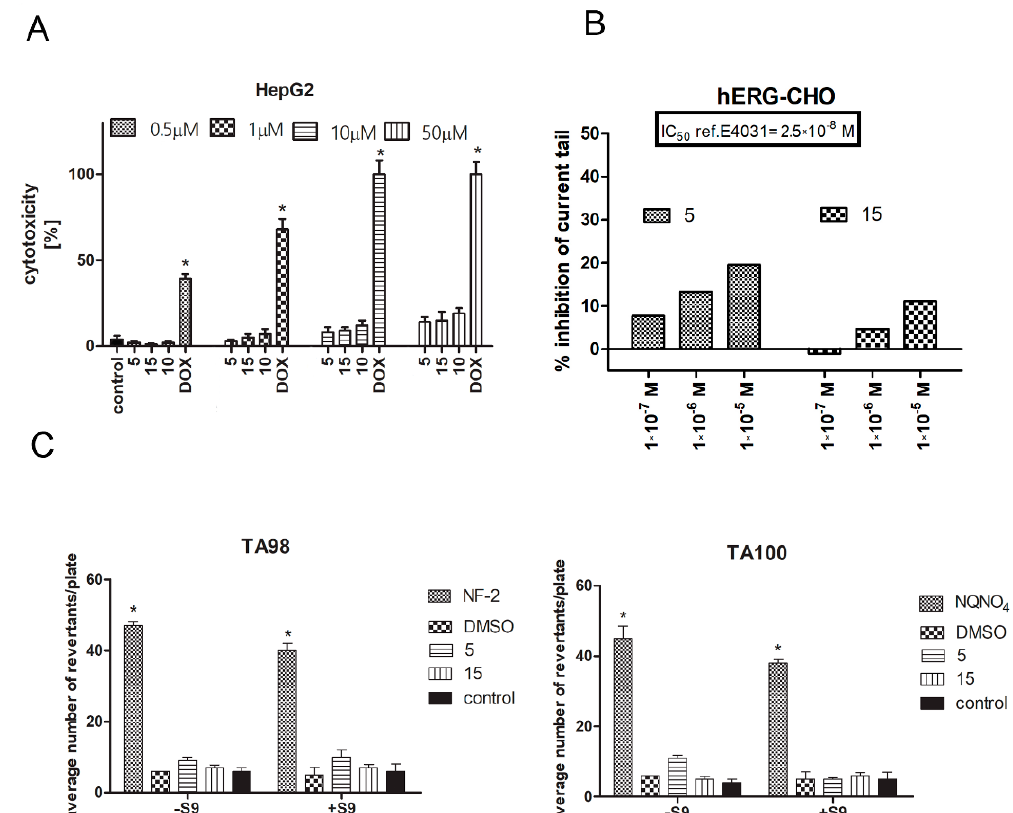
Figure 5. Safety assessment of CA derivatives. Hepatotoxicity analysis was conducted on the HepG2 cell line ( A ). Cells were incubated in the presence of analyzed compounds for 24 h, then the CytoTox-Glo assay was performed. Graph represents the % of cytotoxicity ± SEM of six replicates of three independent experiments. DOX was used as a reference standard. Statistical significance (*) was calculated relative to control ( p < 0.05). ADME-Tox cardiotoxicity was investigated using the hERG-CHO cell line in an automated patch clamp assay performed by Eurofines. The degree of inhibition (%) was obtained by measuring the tail current amplitude, which was induced by a 1-s test pulse to –40 mV after a 2-spulse to +20 mV, before and after incubation with the compounds ( 5 , 15 ) (the difference in current was normalized to control and multiplied by 100 in orderto obtain the percent of inhibition). Compound E4031 was used as a reference standard. The experiment was performed in triplicate ( B ). Mutagenicity of compounds 5 and 15 in the absence (–S9) or presence (+S9) of the S9 fraction using the Ames test. Graphs represent the average number of revertants/plate of TA98 and TA100 bacteria strains growing after incubation with the compounds ± SEM of nine replicates of three independent experiments. Statistical significance (*) was calculated relative to control using the Mann–Whitney test ( p < 0.05). Positive controls used for the MPF protocol were 2-nitrofluorene (2-NF) (TA98, –S9) and 4-nitroquinoline-N-oxide (4-NQO) (TA100, –S9); DMSO was used as the negative control ( C